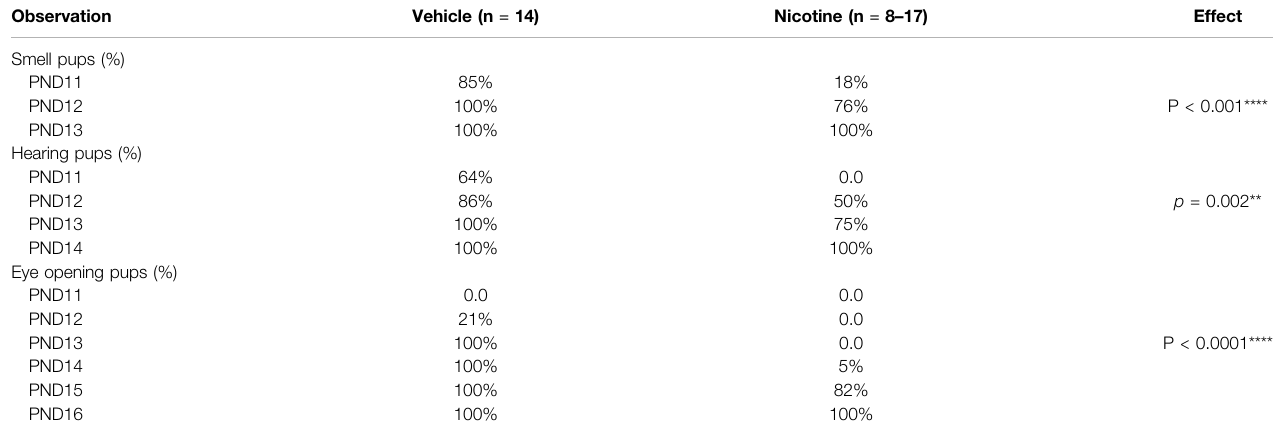
TABLE 3 | Physiological development index in each different